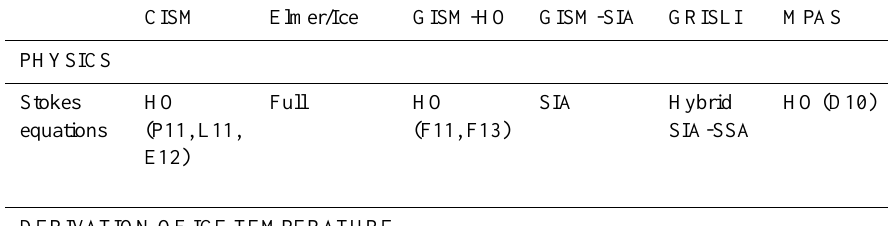
Table 1. Summary of ice sheet model (top) treatment of Stokes equations and (bottom) derivation of ice temperature (IT) boundary conditions. HO, SIA and SSA are higher order, shallow ice and shallow shelf approximations; SS is steady state; SAT is surface air temperature data used for the spin-up simulation; g–ig is glacial–interglacial. All models use bedrock elevation data from Bamber et al. (2013) and geothermal heat flux from Shapiro and Ritzwoller (2004). References: B13: Bamber et al. (2013); D10: Dukowicz et al. (2010); E09: Ettema et al. (2009); E12: Evans et al. (2012); F11, F13: Fürst et al. (2011) and Fürst et al. (2013); G97: Greve (1997); L11: Lemieux et al. (2011); P11: Price et al. (2011). CISM Elmer/Ice GISM-HO GISM-SIA GRISLI